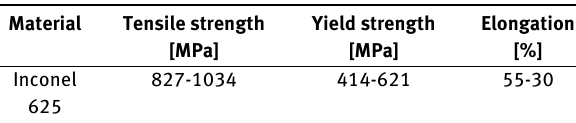
Table 2: Mechanical properties of Inconel 625 (nominal room tem- perature)